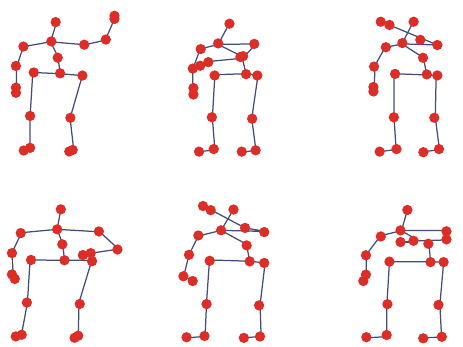
Figure 2: Examples of Kinect data from aerobics